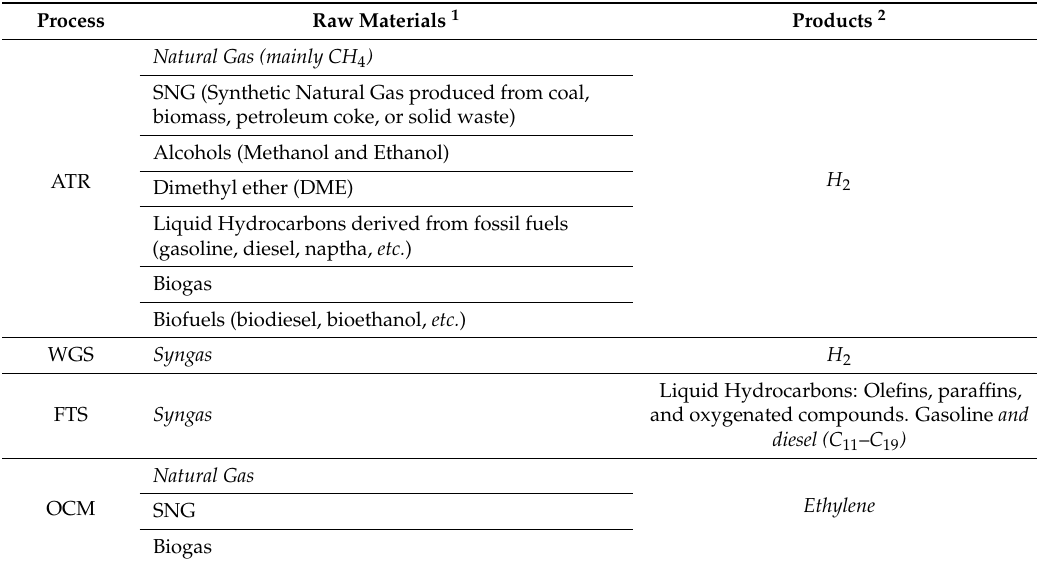
Table 1. Raw materials and obtained products per each targeted